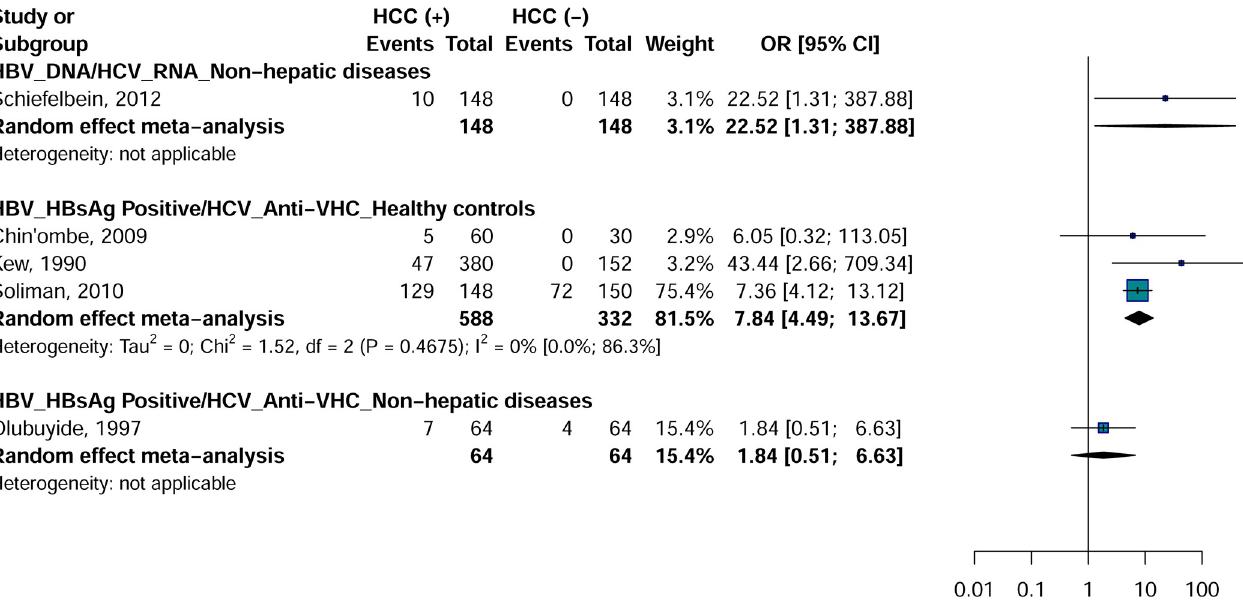
Fig 4. Association between Hepatitis B and C Virus coinfection and risk of hepatocellular carcinoma in Africa.